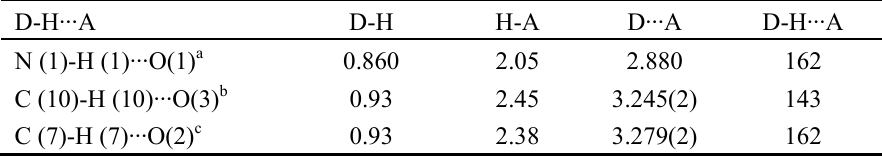
Table 3. Hydrogen Bond Lengths (Å) and Bond Angles